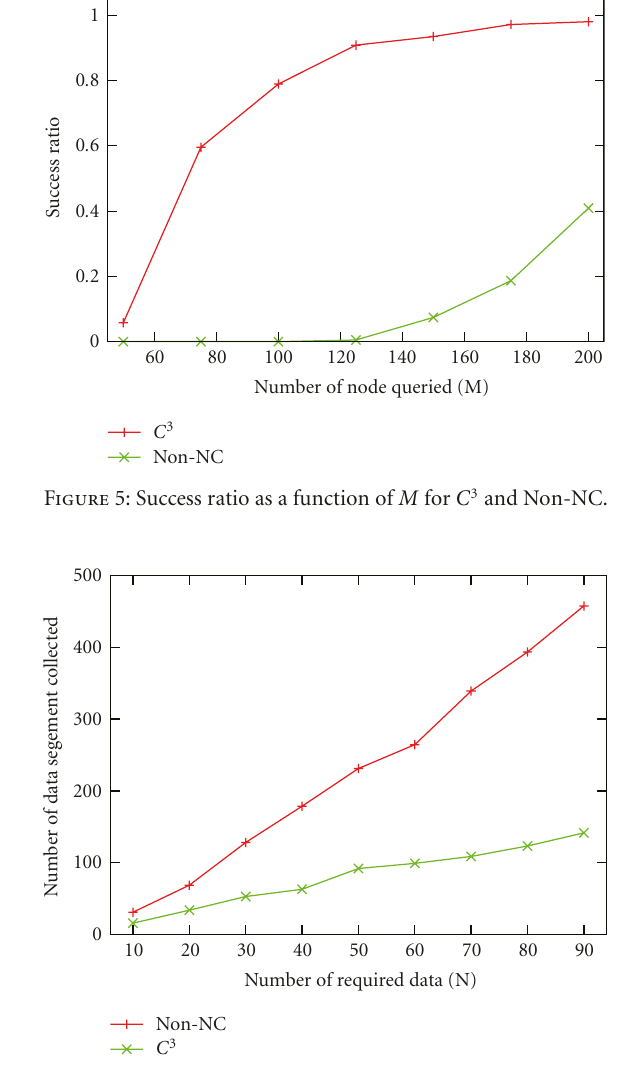
Figure 6: Number of combined data segment retrieved as a function of N